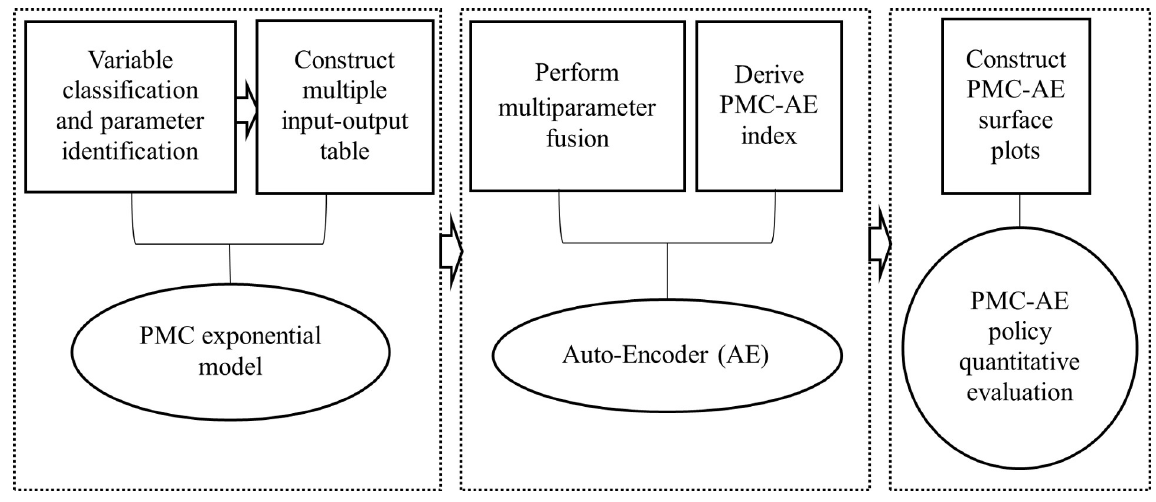
Fig 1. PMC-AE index model construction process.